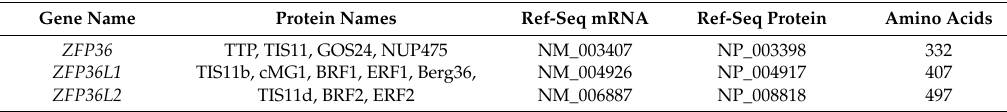
Table 1. Human tristetraprolin (TTP) family RNA-binding